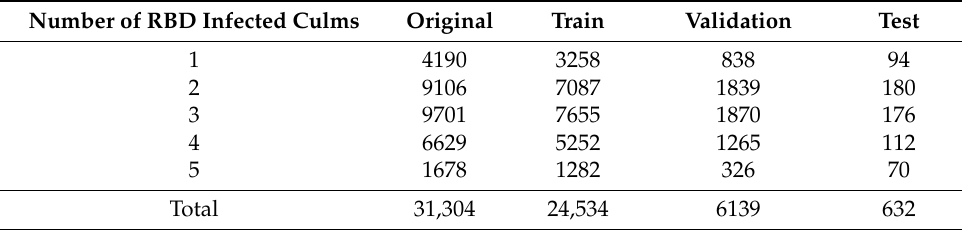
Table 10. The reconstructed number of RBD infected culm classification training and evalua- tion